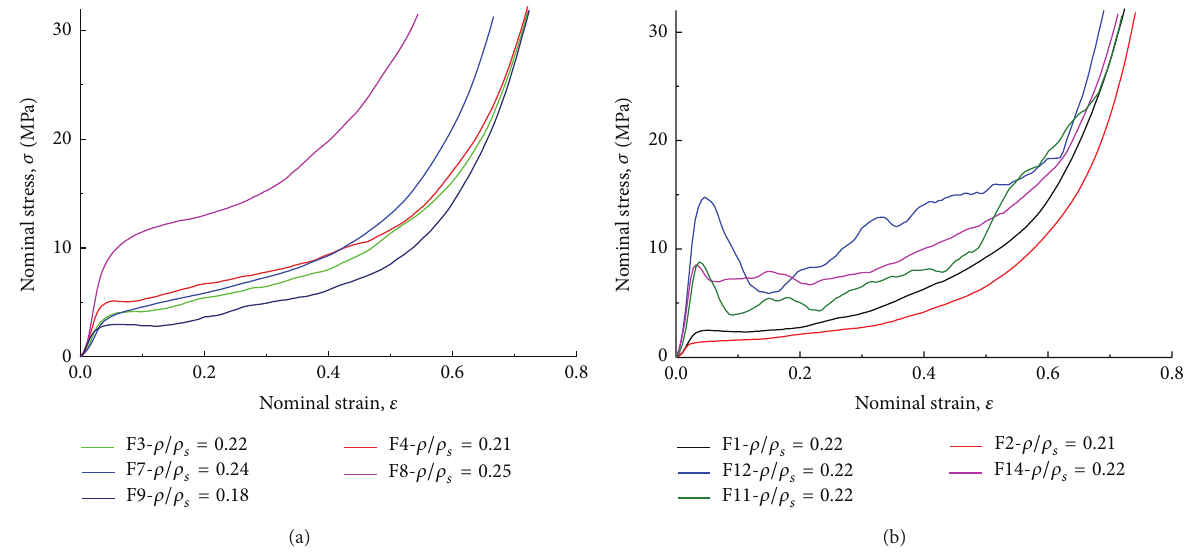
Figure 2: Compressive stress-strain curves for hydride (F1, F3, F4, F11, and F12) and carbonate (F2 and F14) kinds of Al/Al-alloy foams processed with (F1–F3, F7, and F11) and without (F4, F8, F12, and F14) Ca additive: (a) Al-foams based on Al-7Si alloy (F3 and F4), Al-1Mg- 0.6Si alloy (F7 and F8), Al-5Mg alloy (F9); (b) Al-foams based on pure Al (F1, F2) and Al-Zn-Mg alloy (F11, F12, and